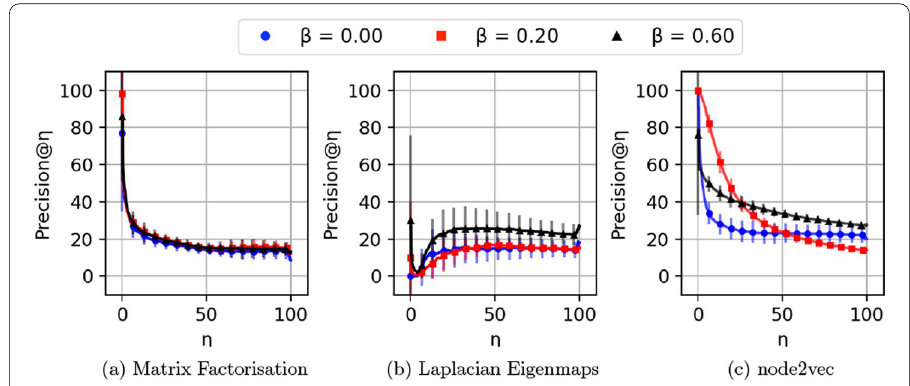
Fig. 8 Precision @ η obtained for network reconstruction, in average, applying each method to each generated data set ( γ = 2.50 ). η is expressed in percentage